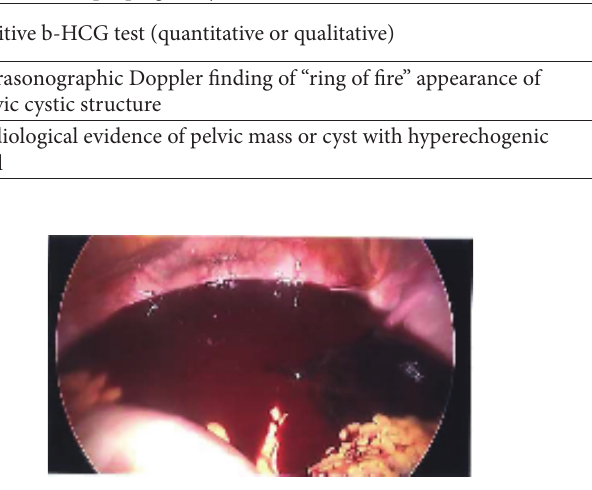
Figure 1: Pelvic haemoperitoneum and clots.